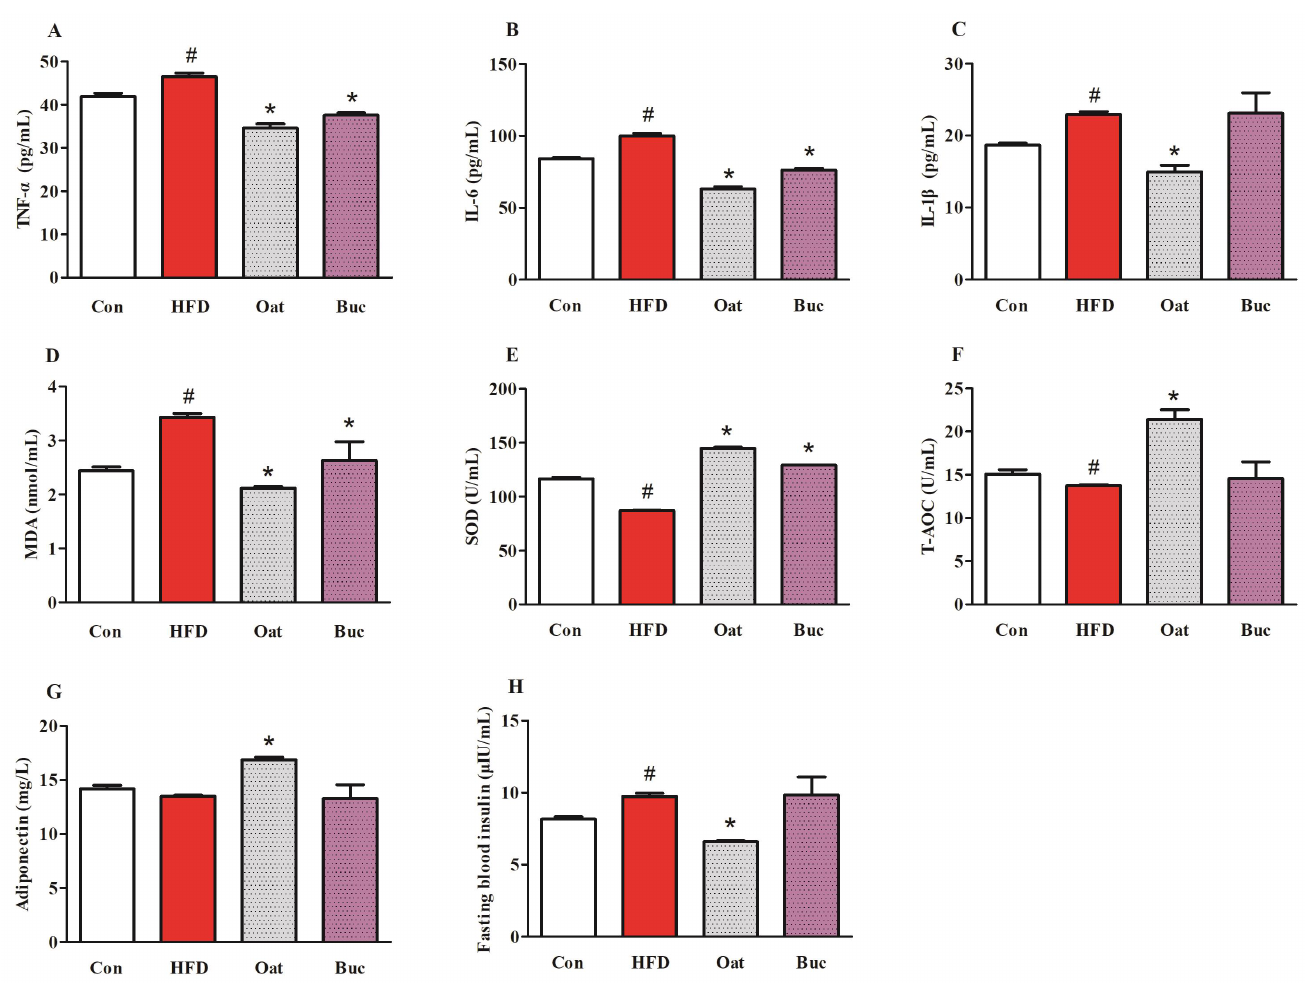
Figure 4. Effect of oats and tartary buckwheat supplementation on serum TNF- α ( A ), IL-6 ( B ), IL-1 β ( C ), MDA ( D ), SOD ( E ), T-AOC ( F ), adiponectin ( G ), and fasting blood insulin ( H ) in high-fat diet fed rats. Con group, a basal diet group; HFD group, a high-fat diet group; Oat group, HFD containing 22% oat group; Buc group, HFD containing 22% tartary buckwheat group; TNF- α , tumor necrosis factor-alpha; IL-6, interleukine-6; IL-1 β , interleukin-1 β ; MDA, malondialdehyde; SOD, superoxide dismutase; T-AOC, total antioxidant capacity. Data are presented as the mean ± SD ( n = 10). # p < 0.05, compared to Con group, * p < 0.05, compared to HFD